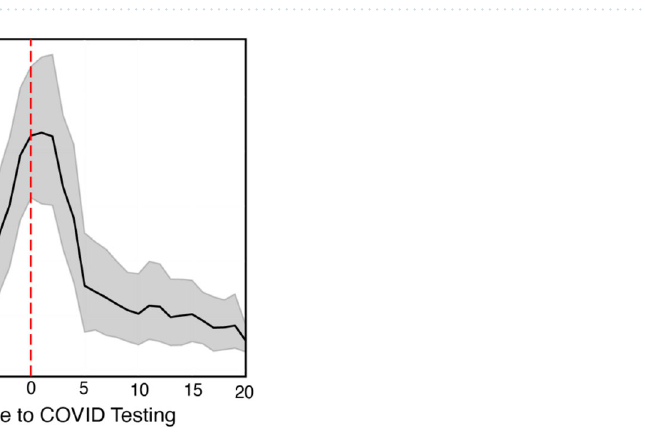
Figure 8. ( a ) ROC curve of the algorithm for each fold. Dash line represents guessing. AUC is indicated for each fold in the legend. ( b ) Infection predictive model performance. Random model results based on dummy classifier using stratified approach with random guessing proportional to the class distribution/prevalence (~ 9%).